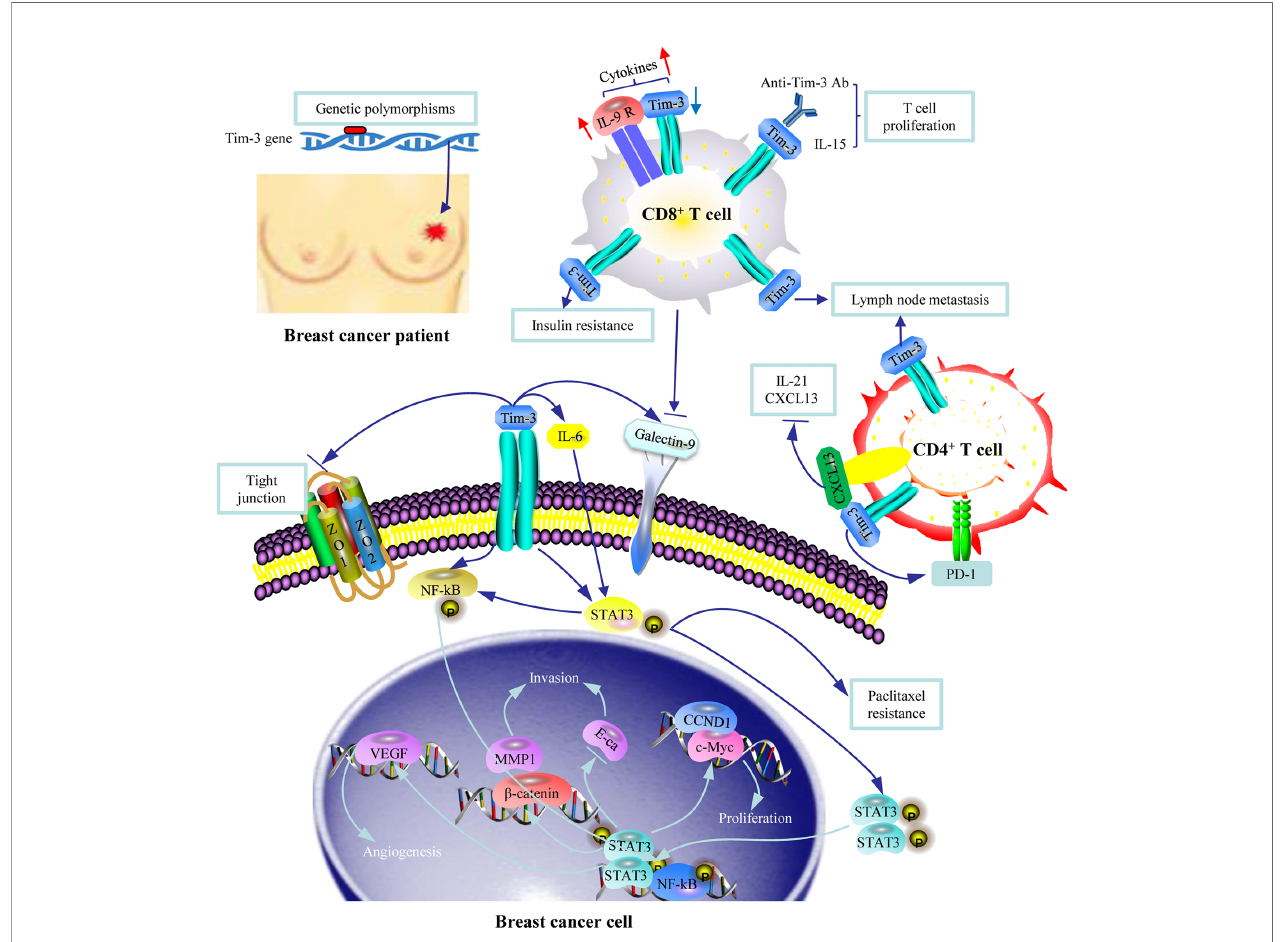
FIGURE 1 | An illustration of the role of Tim-3 in breast cancer. Genetic polymorphisms in Tim-3 are associated with susceptibility to breast cancer. Tim-3 + CD8 + T cells and Tim-3 + CD4 + T cells are associated with risk of lymph node metastasis through Tim-3 mediated immune escape. Tim-3 is involved in insulin resistance. Tim-3 overexpression in breast cancer cells promotes cell proliferation, migration, invasion, tubal formation, and enhanced chemoresistance to paclitaxel by activating the NF- k B/STAT3 signaling pathway. The Tim-3-galectin-9 (Gal-9) pathway is involved in tumor progression given the surface-based Gal-9 protects breast carcinoma cells against cytotoxic T cell-induced